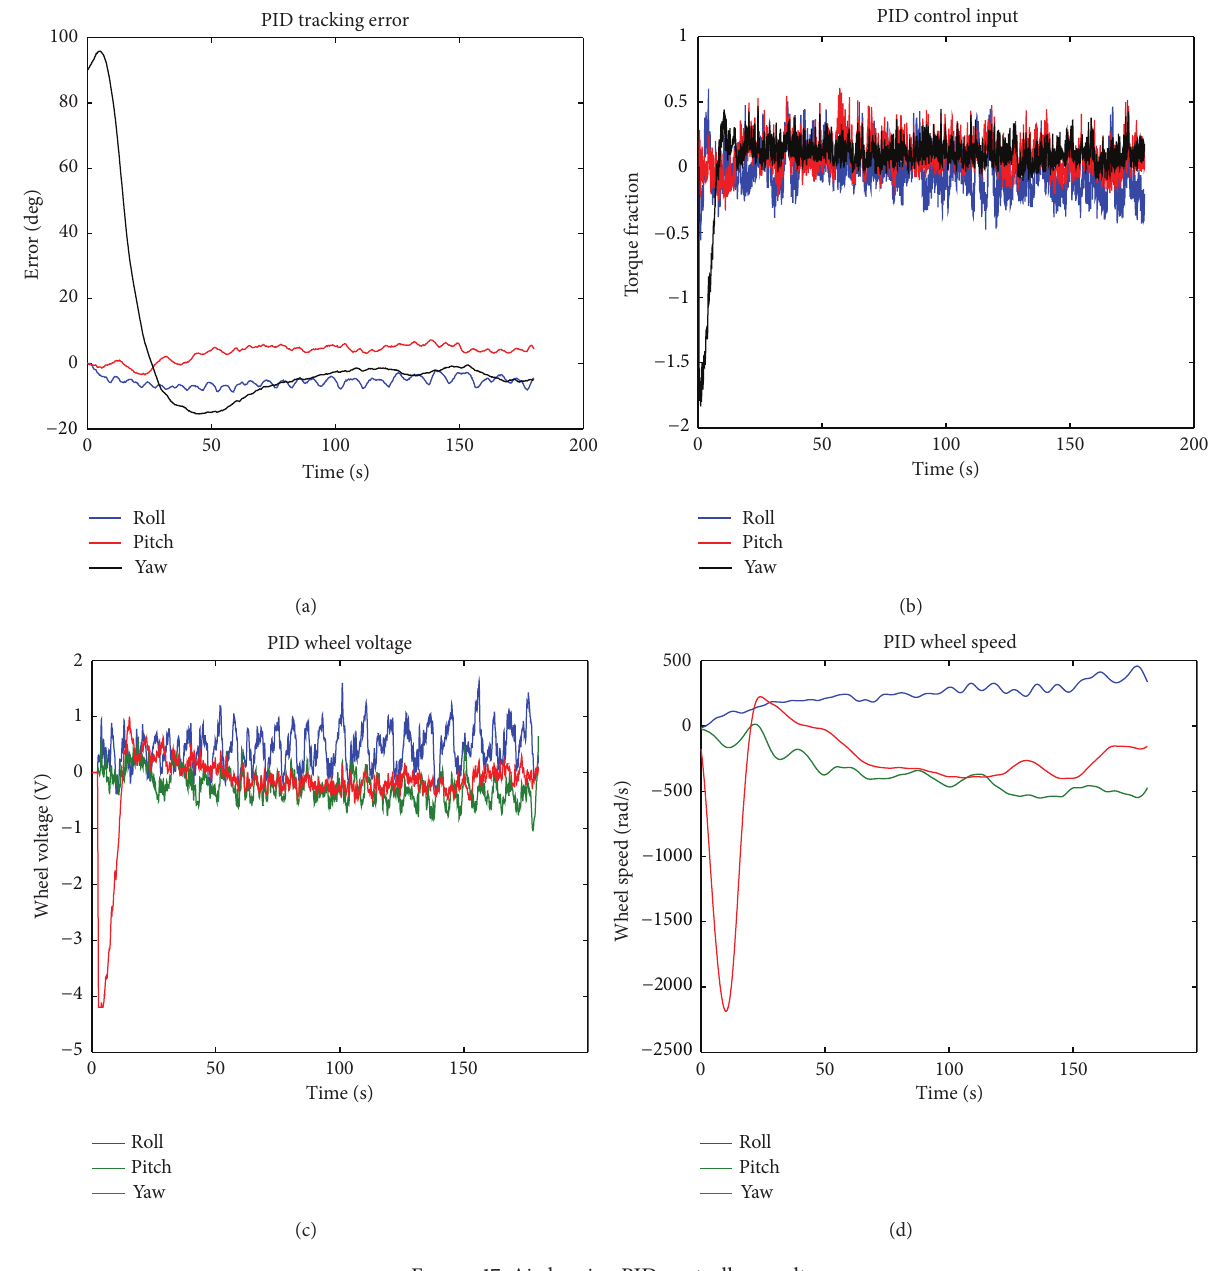
Figure 17: Air-bearing PID controller